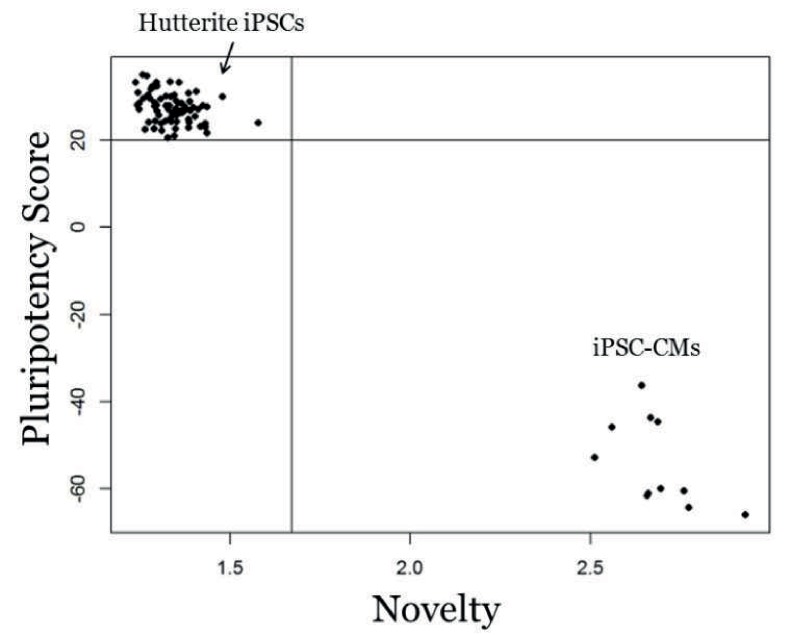
Genome-wide expression analysis of iPSCs using PluriTest.PluriTest quality control of iPSCs. PluriTest pluriscore and novelty results shows all iPSC samples fall within the pluripotent and novelty threshold (black lines). All cell lines received a pluripotency score above the pluripotency classification threshold of 20 (average = 27.38) and showed low novelty scores below the threshold of 1.67 (average = 1.34). As a comparison, a subset of the iPSC-cardiomyocytes fall outside of the pluripotency classification for both pluriscore and novelty.